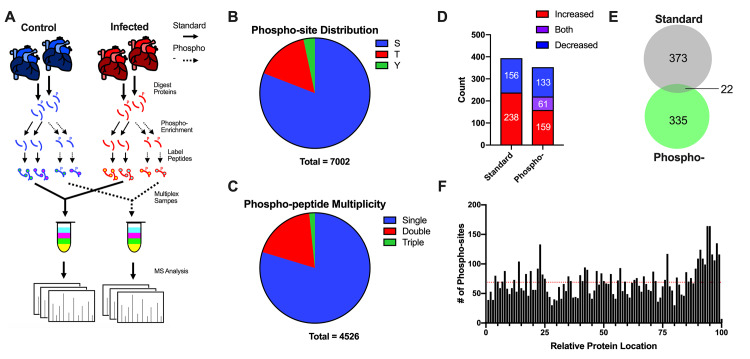
Overview of dual proteome/phospho-proteome analyses.A, Schematic of phospho-proteomic analysis workflow. B, Distribution of phospho-sites detected in this experiment. C, Multiplicity of phospho-peptides detected in this experiment. D, Numbers of significantly altered (pi score < 0.05) proteins and phospho-proteins. E, Venn diagram of significantly altered proteins and phospho-proteins. F, Relative protein locations of phospho-sites detected in this experiment.